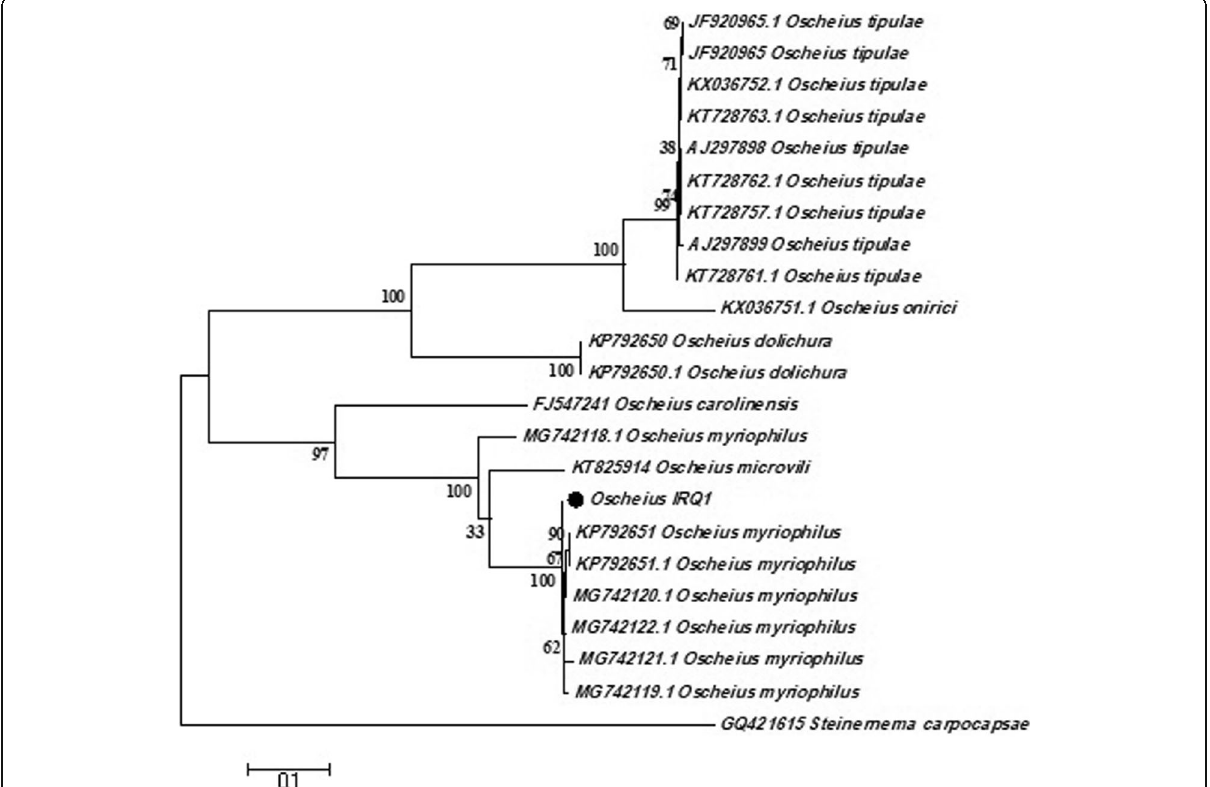
Fig. 3 Phylogenetic relationships of Oscheius isolate with 28 taxa based on ITS-rDNA sequences as inferred from maximum likelihood (ML) analyses. Steinernema carpocapsae (GQ421615) was used as the outgroup. Support values are presented near the nodes in the form: bootstrap in